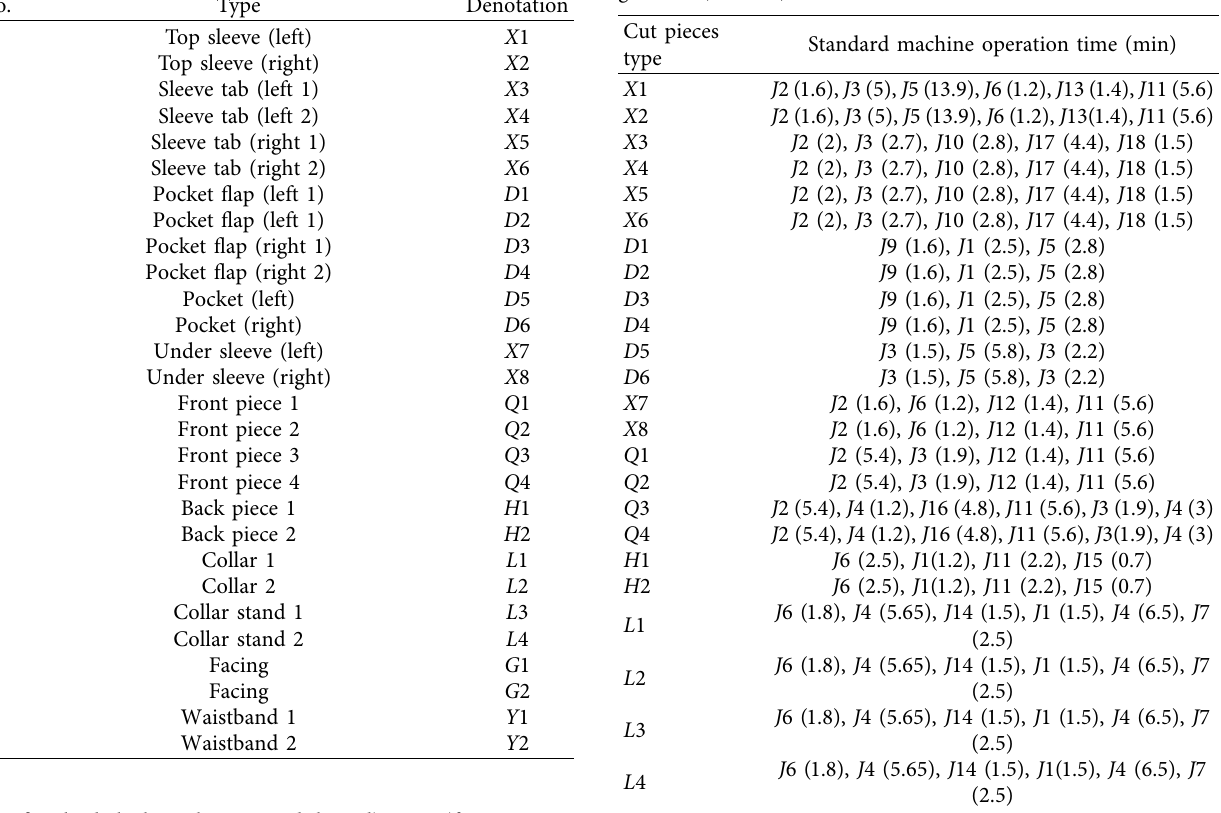
Table 4: Type of cut pieces. Table 5: Sewing process and machine operation time for women’s garment ( 18SSF-1